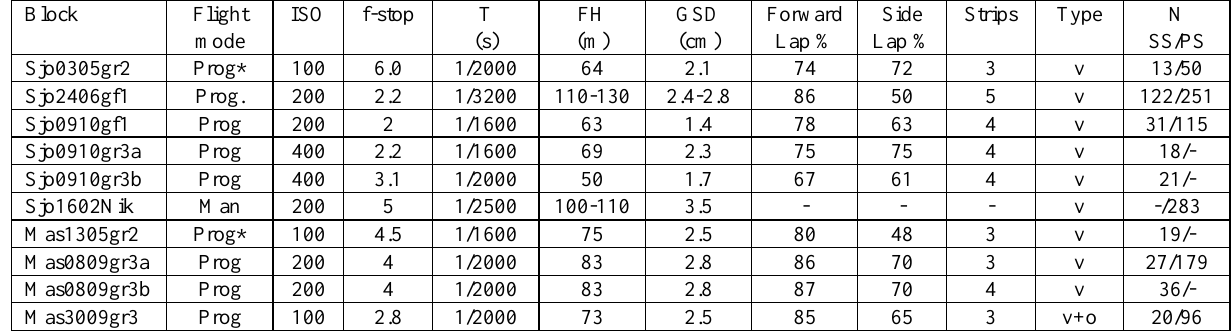
Table 3. Details of image blocks. Prog: Preprogrammed flight plan; Man: Visual control from ground; Man vid: manual flight aided by live video; *: images were taken in stop-and-go mode; T: exposure time; FH: flying height; N SS/PS: number of images in SOCET SET and Photosynth processing; Type: block type oblique (o) or vertical (v). Block details are for the vertical block that was used in SOCET